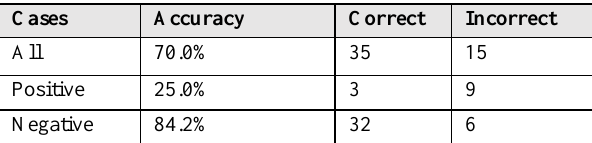
Table 3 . Accuracy of the solar panel detection for the